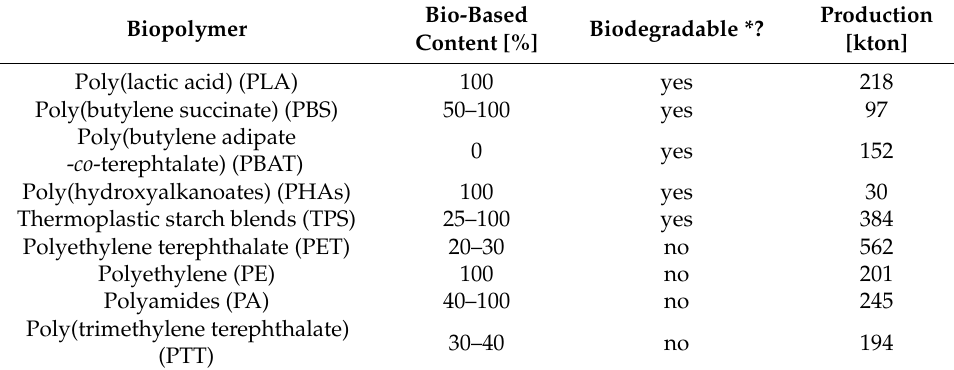
Table 1. Bio-based content, biodegradability (yes/no), and production data (2018) [11,12] of the important